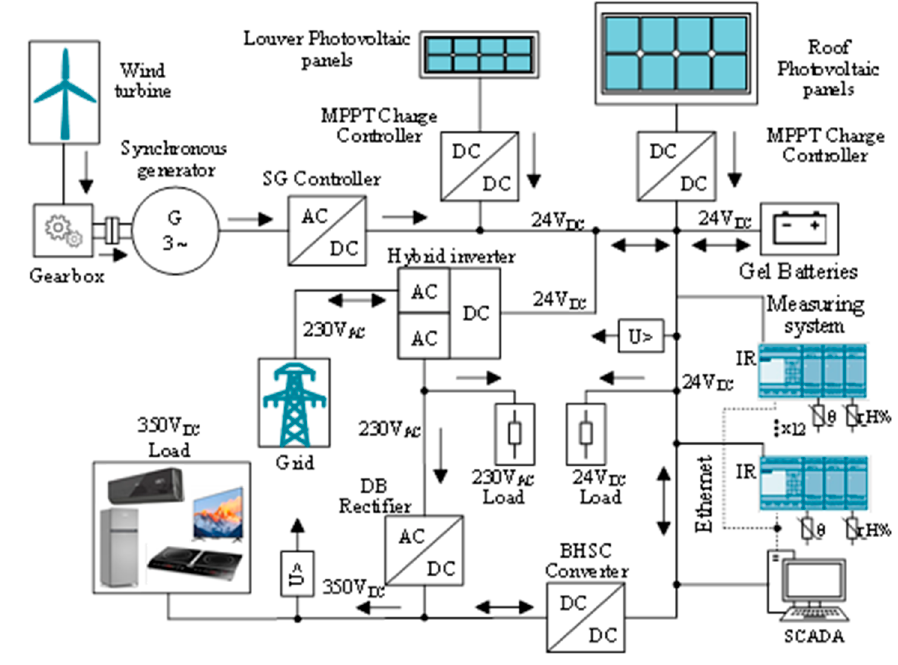
Figure 10. The architecture of the implemented smart nano ‐ grid (adapted from